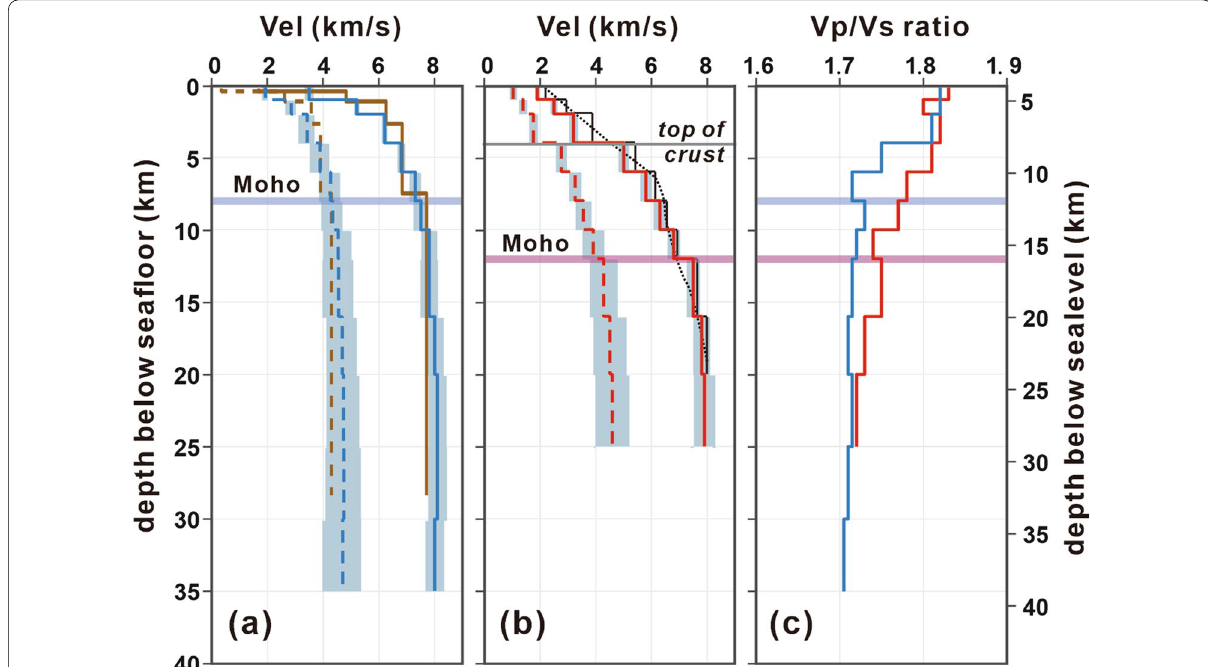
Fig. 3 Layered seismic wave (P- and S-waves) velocity models ( a and b ) and V p / V s ratio versus depth ( c ). The solid and dashed lines in the velocity models represent the P- and S-wave velocities, respectively. The red and blue lines in the V p / V s ratio plot represent the values from C2005 and C2006. Both the scales of depth from sea level and the seafloor are indicated. The gray-blue shadows along with the P- and S-wave velocity models indicate the uncertainties of the retrieved models. The velocity models for typical oceanic crusts are adopted from Laske et al. (2013); the models are indicated in a by brown lines. The initial velocity model (P-wave velocity) is adopted from Eakin et al. (2014); the model is indicated by the black line and black dashed line (modified by depth layers) in